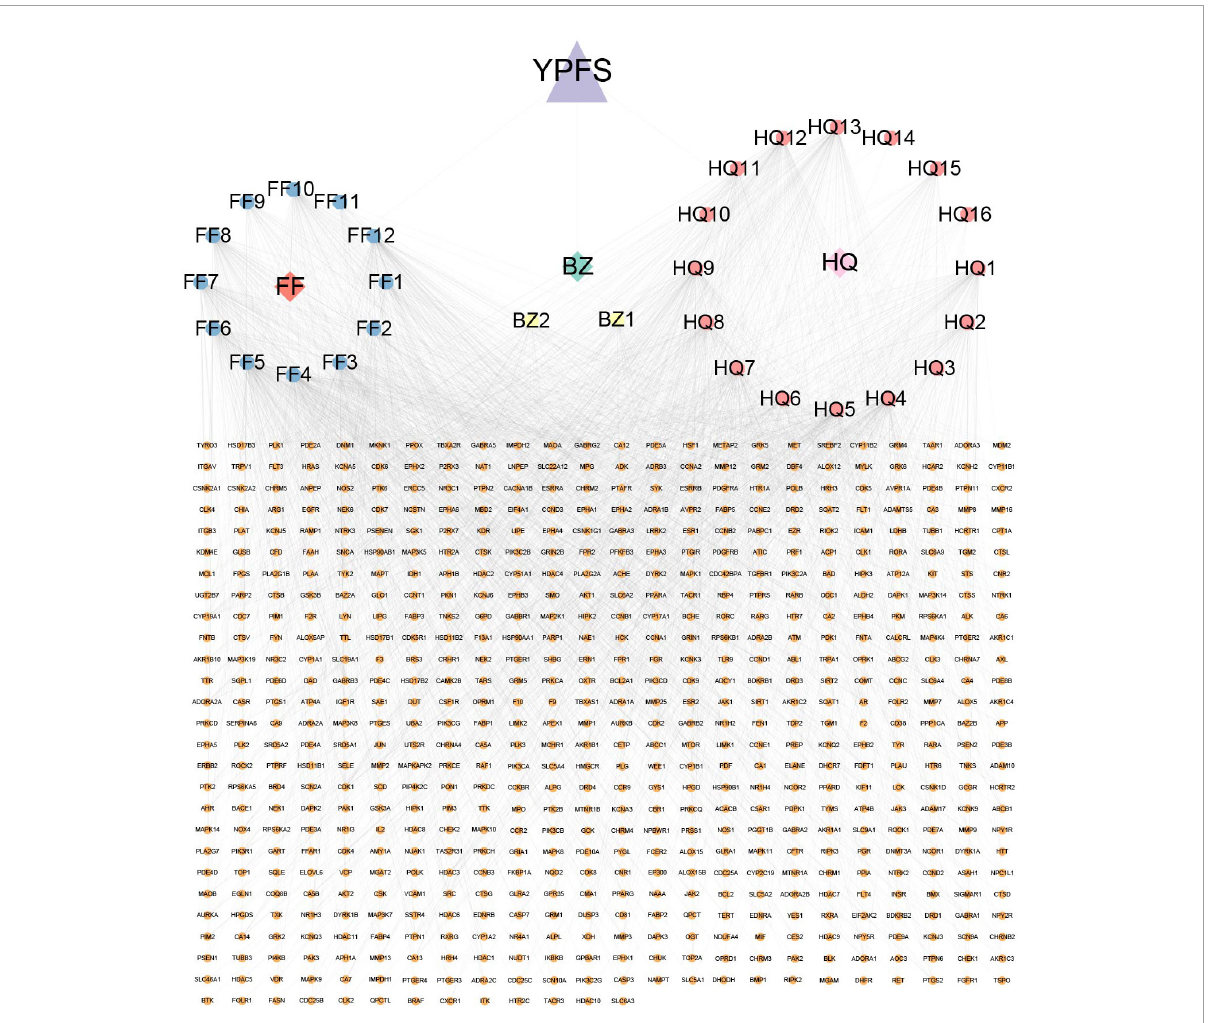
FIGURE2 A network diagram was constructed with 3 active components, 30 active ingredients, and 637 target genes of these active ingredients using Cytoscape. The blue, yellow, and pink octagons represent the active ingredients of the three herbs in YPFS. FF1-12 are active ingredients of Saposhnikoviae Radix (Fangfeng, FF), BZ1-2 are active ingredients of Atractylodis Macrocephalae Rhizoma (Baizhu, BZ), and HQ1-16 are active ingredients of Astragali Radix (Huangqi, HQ). The full names of the corresponding active ingredients are listed in Supplementary Table 7 . The orange circles represent YPFS-related genes, and the edges represent the interactions between the ingredients and the target genes. YPFS, YU-Pingfeng San.